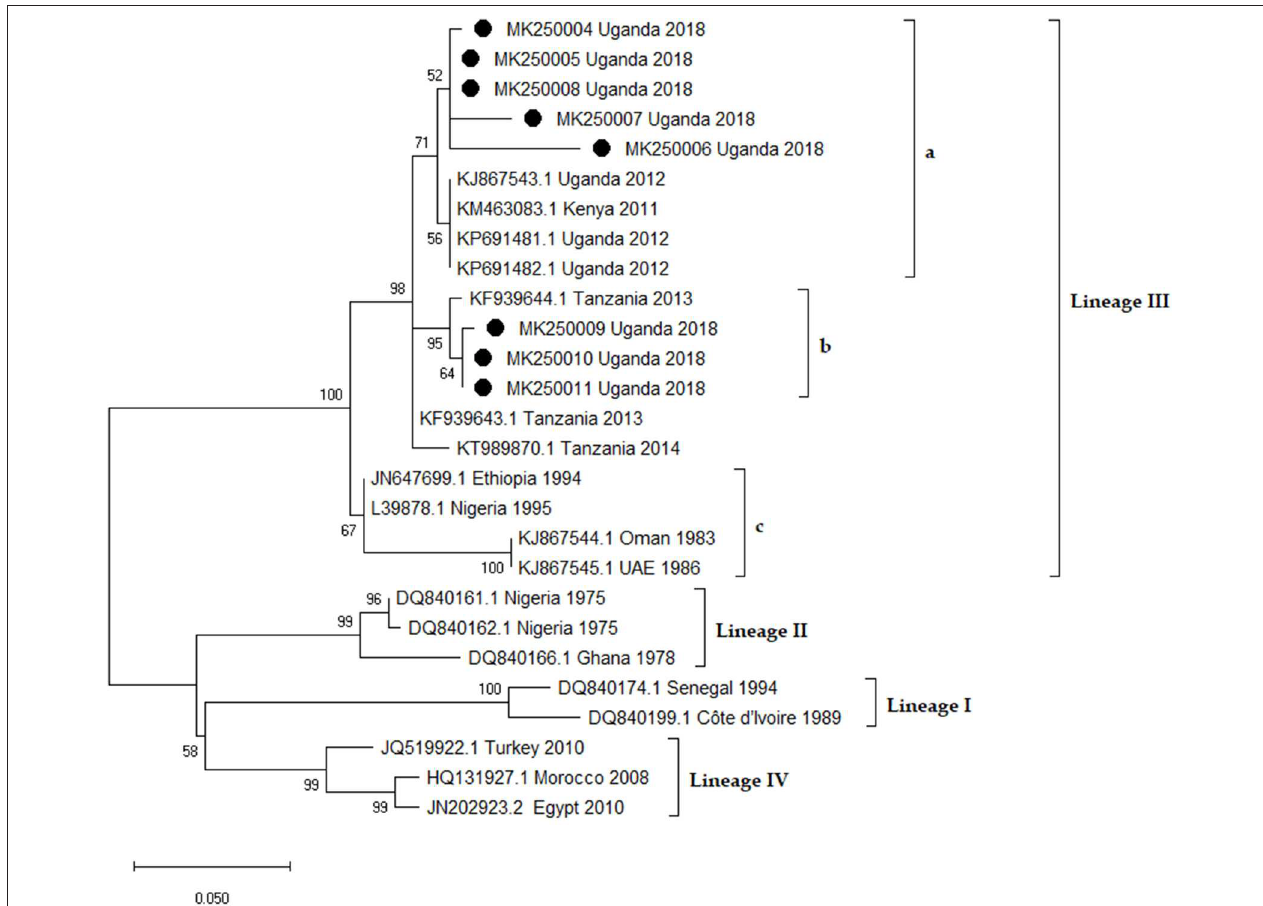
FIGURE 9 | Phylogenetic analysis of Peste des petits Ruminants virus Nucleoprotein (N) gene fragment in MEGA X software. The Maximum Likelihood method and the Kimura 2-parameter [ + I] models were selected to best infer evolutionary relationship. The tree is drawn to scale, and the branch lengths correspond to the number of nucleotide substitutions per site. Bootstrap values of 1,000 replicates are indicated at each node. The rate variation model allowed for some sites to be evolutionarily invariable ([ + I], 30.00% sites). This analysis involved 27 nucleotide sequences and their accession numbers and countries of origin are indicated. The sequences from this study are denoted by black circles [ • ] and they form two sub-clusters (a and b) in lineage III. Sub-clusters a and b are from the southern and northern foci,